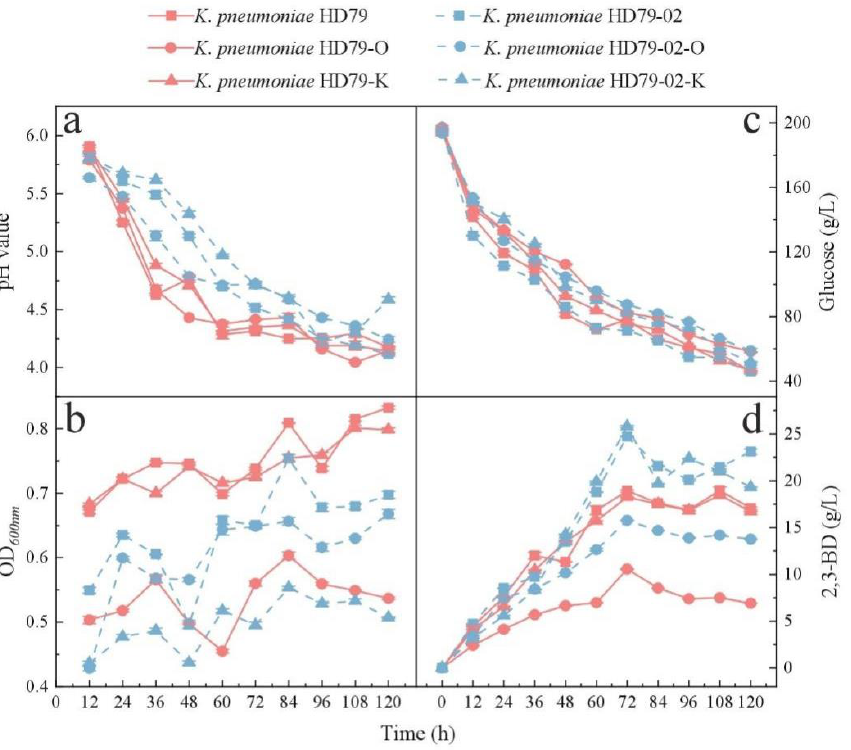
Figure 4. Fermentation of K. pneumoniae HD79 series strains and K. pneumoniae HD79-02 series strains. Variation curves of pH, OD 600nm , glucose residue, and 2,3-BD concentration are shown in ( a – d ), respectively. The pink box represents K. pneumoniae HD79 strain, the pink cycle represents K. pneumoniae HD79-O strain, the pink triangle represents K. pneumoniae HD79-K strain, the blue box represents K. pneumoniae HD79-02 strain, the blue cycle represents K. pneumoniae HD79-02-O strain, and the blue triangle represents K. pneumoniae HD79-02-K strain. The experiments were performed in triplicate, and the error bars represent the standard deviations.